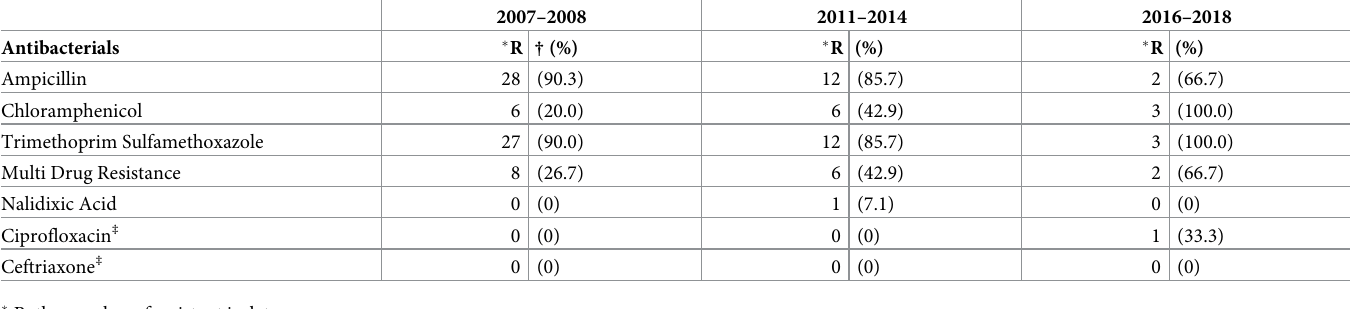
Table 3. Antimicrobial resistance of Salmonella Typhi Isolates, Kilimanjaro Region, Tanzania, 2007–2018.